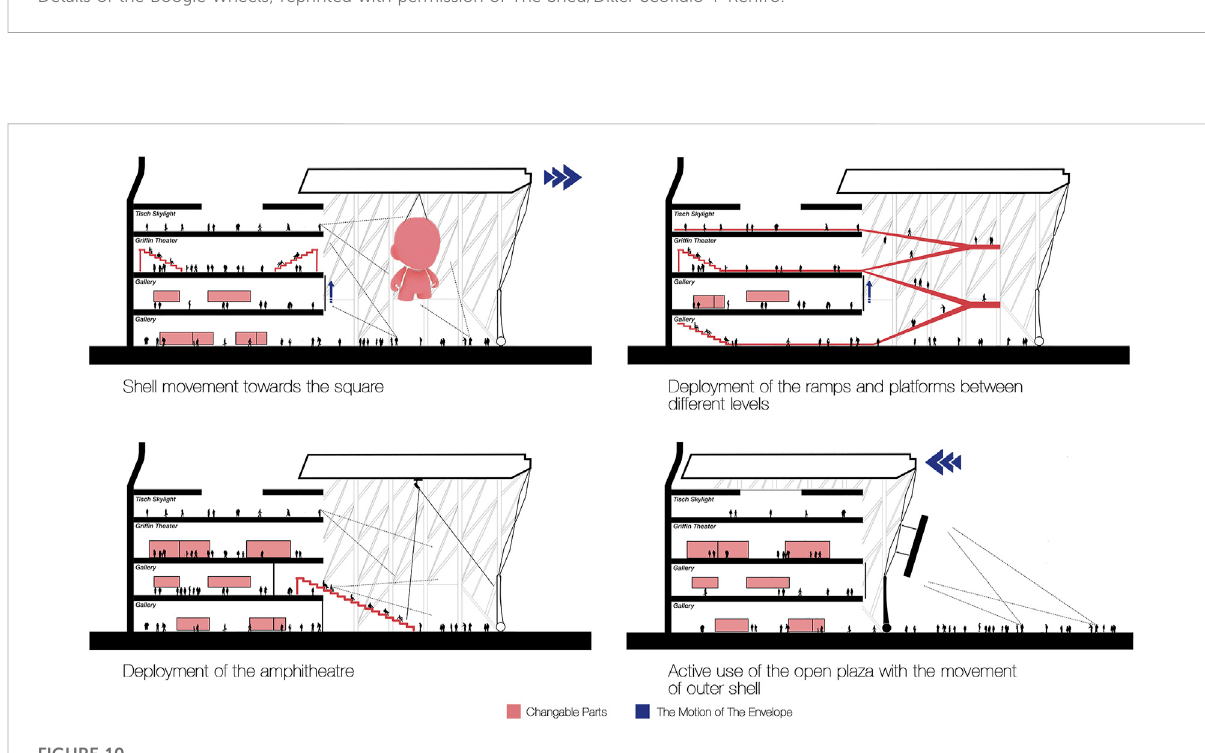
FIGURE 10 The Interplay of Movable and Immovable Parts (drawn by the